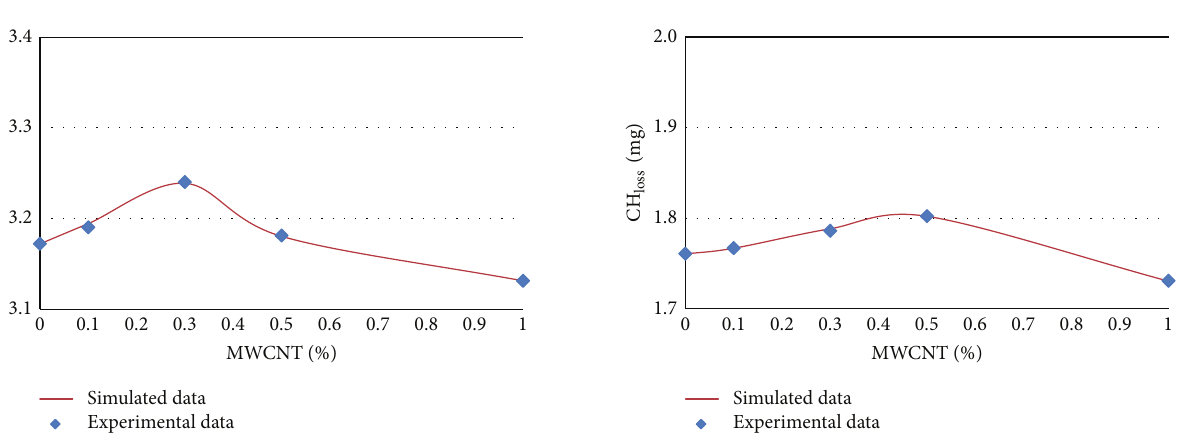
Figure 7: Experimental and simulated values of PHP by artificial neural networks.